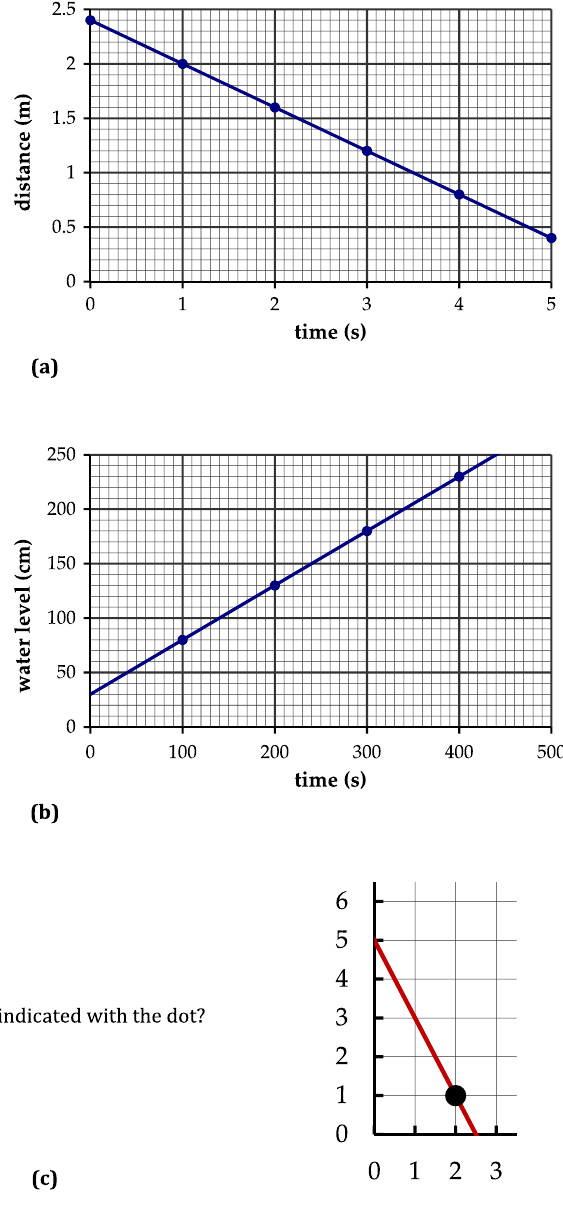
FIG. 1. English version of questions used to investigate approaches to kinematics graphs at KU Leuven and UPV/EHU: a linear distance-time graph (ball context) with negative slope (a), a water level versus time graph (swimming pool context) with a positive slope (b), and a context-free graph (c). The questions are taken from